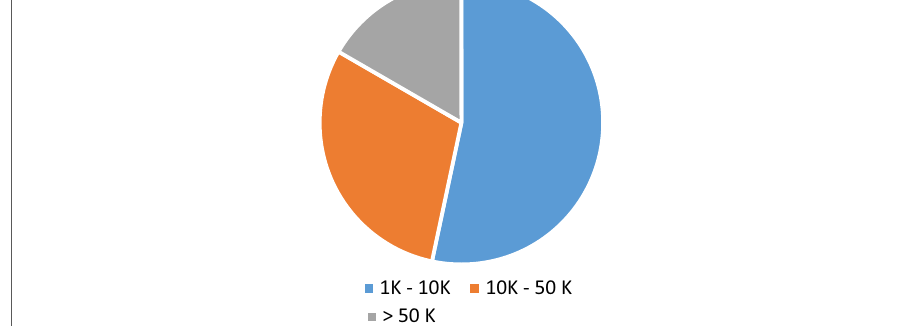
Fig. 11 Distribution of the participants of our study with respect to the number of